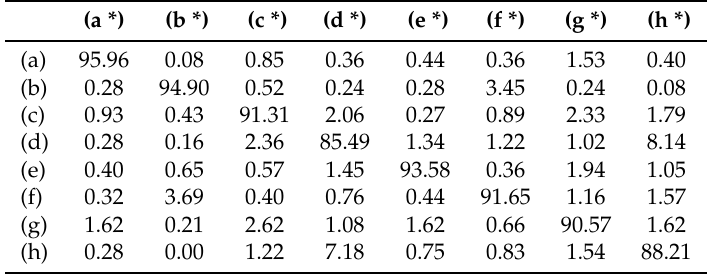
Table 4. The confusion matrix of the stacking method (*: Estimated class, Unit: %).